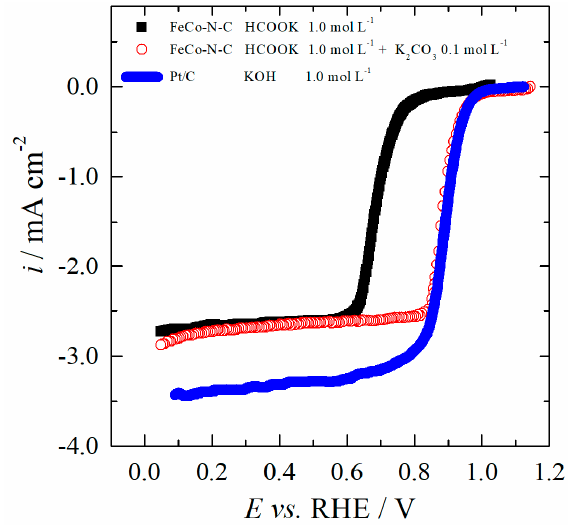
Figure 7. Steady ‐ state polarization curves for the ORR on FeCo ‐ N ‐ C obtained in O 2 ‐ saturated 1.0 mol L − 1 HCOOK + 0.1 K 2 CO 3 (red cycles), and in 1.0 mol L − 1 HCOOK electrolyte (black squares). The curve for Pt/C obtained in 1.0 mol L − 1 KOH was included for comparison. Scan rate: 5.0 mV s − 1 . Rotation rate: 1600 rpm.